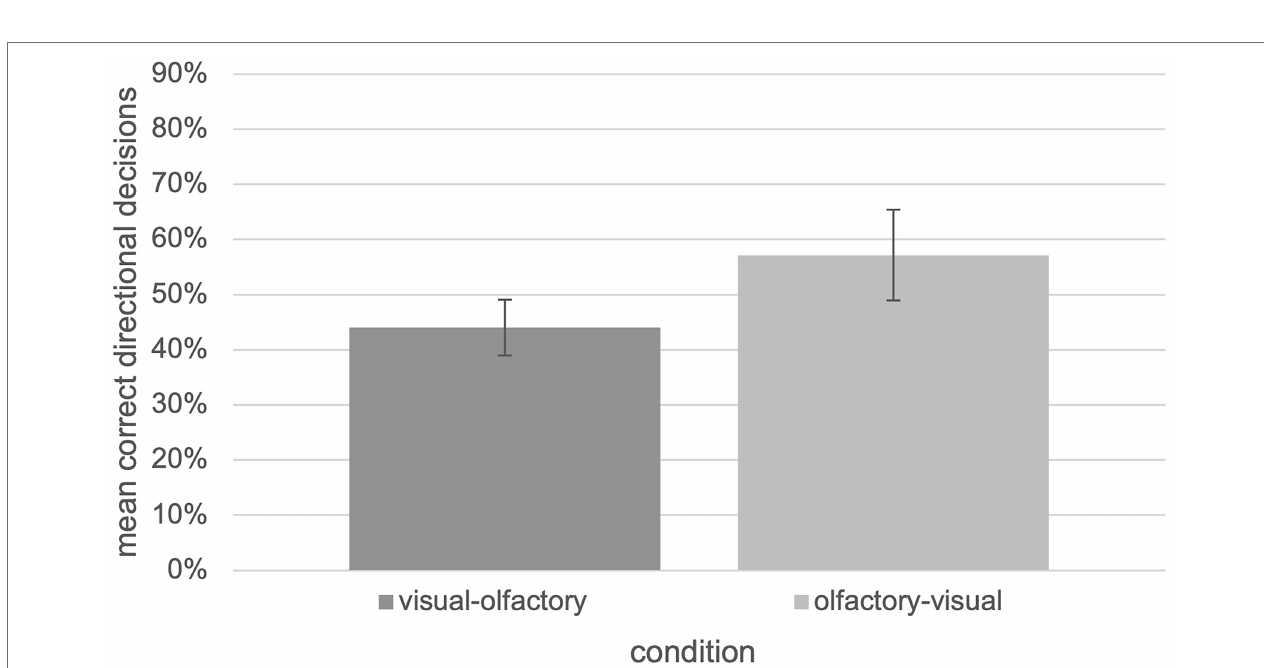
FIGURE 5 | Relative number of correct decisions with respect to the “switch” and “no switch” condition of the tested experiment ( N = 30, error bars = SEM).